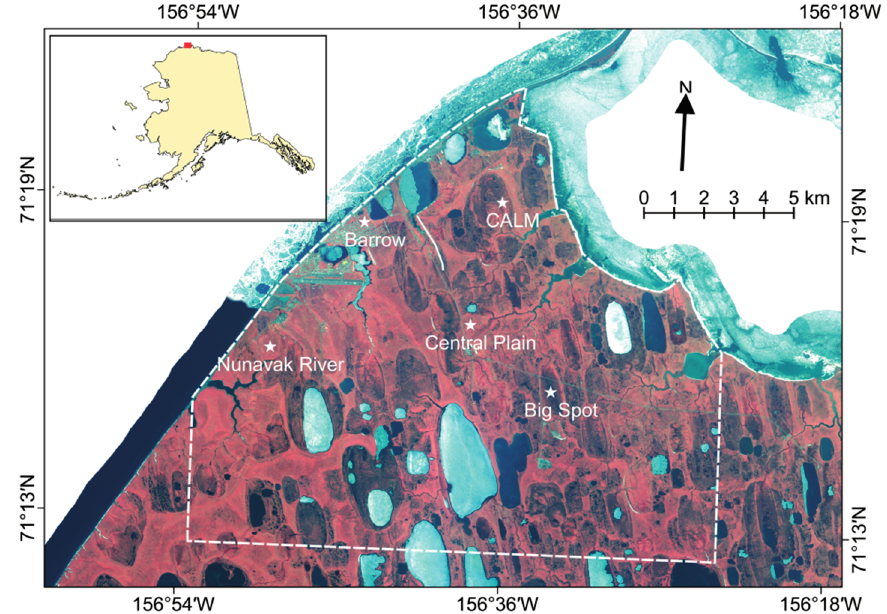
Figure 1. The Remotely Sensed Active Layer Thickness (ReSALT) domain around Barrow, Alaska (dashed line) and the locations of the four validation